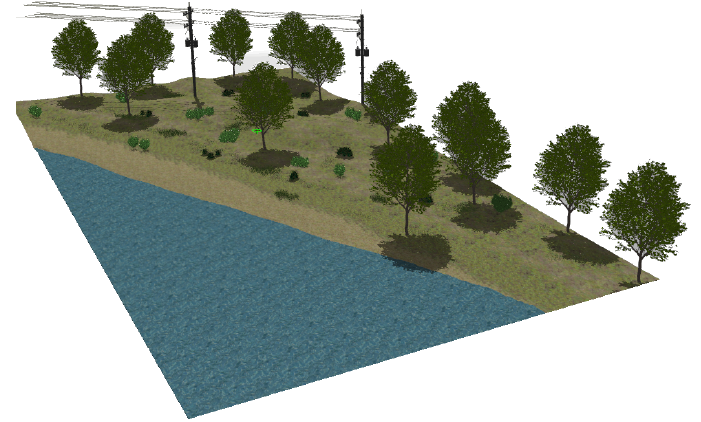
Figure 5. The lake’s shore environment modeled in